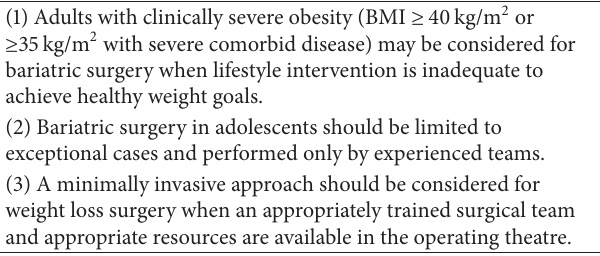
Table5:CDA’sClinicalPracticeGuidelinesSuggestionsforbariatric